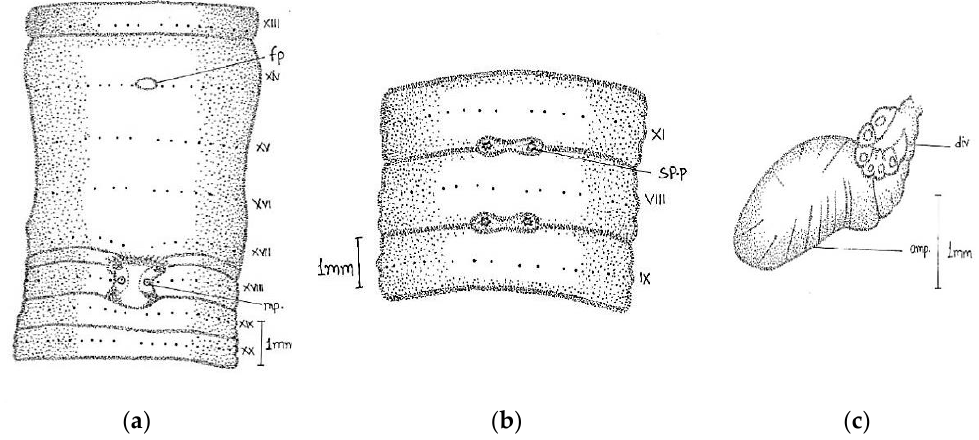
Figure 11. Camera lucida illustration of Megascolex triangularis ( a ) genital region; ( b ) spermathecal region; ( c )